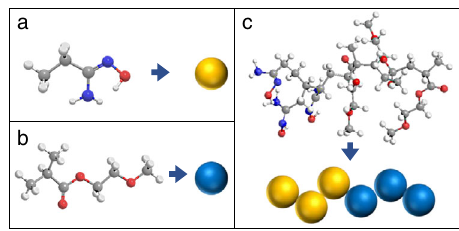
Fig. 2 Schematic illustration of the coarse-grained models. a AO-bearing segment. b PEG-bearing segment. c PAO m - b -PPEGMA n .